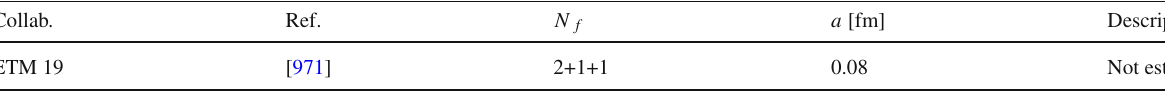
Table 184 Continuum extrapolations/estimation of lattice artifacts in determinations of g q Collab.